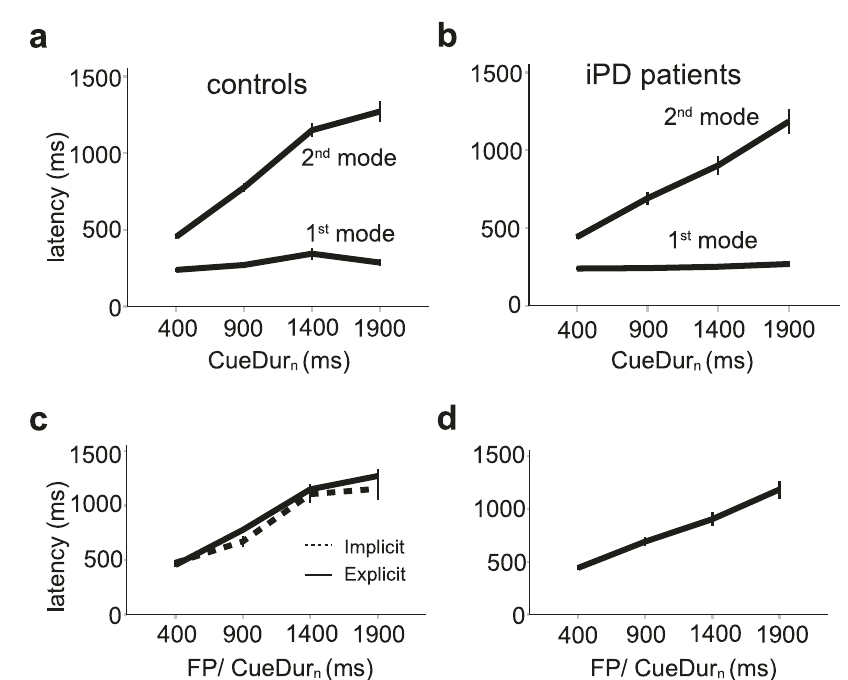
Fig. 5 Aggregated data. Upper part: average saccadic latency of 1 st (red lines) and 2 nd mode responses (blue lines) as a function of CueDur n in controls ( a ) and iPD patients ( b ). Lower: comparison of 2 nd mode average latencies in the implicit ( dashed curves ) and explicit conditions (continuous curves) in controls ( c ) and iPD patients ( d ). Error bars: 95% con fi dence interval of the